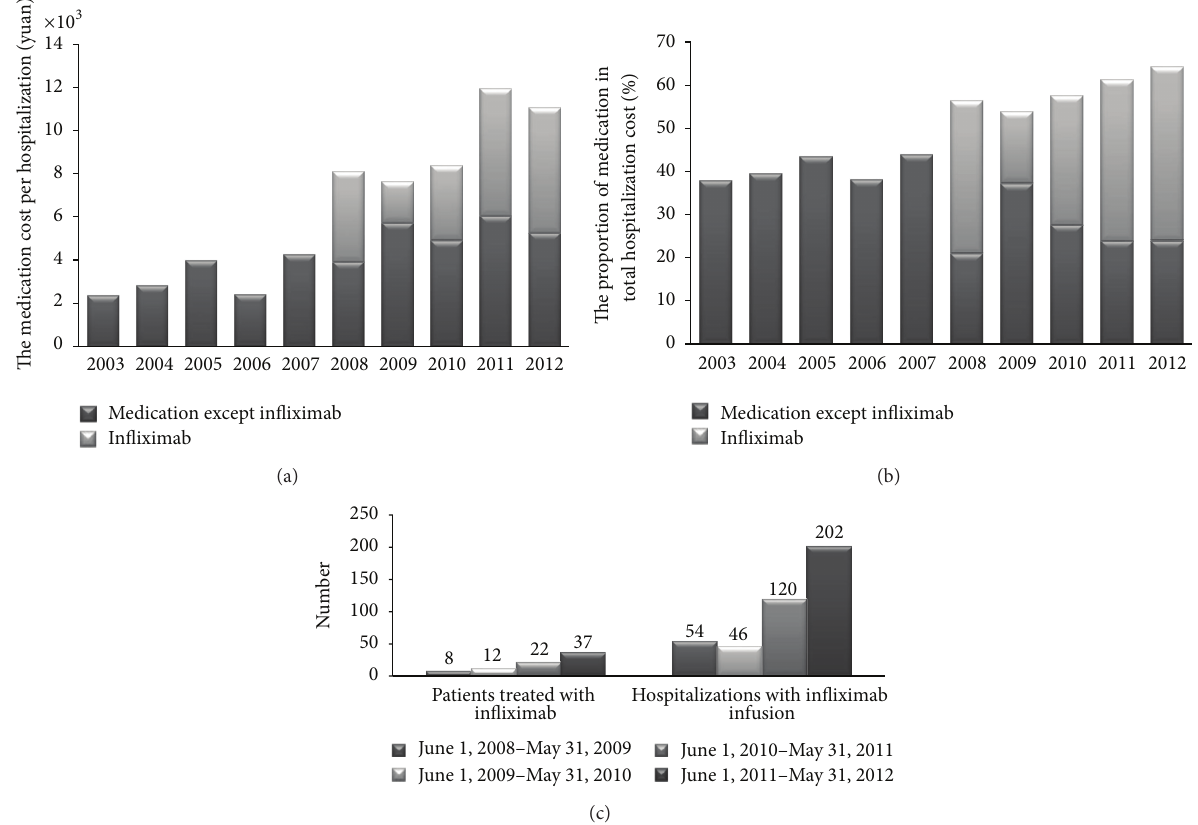
Figure 4: Medication and infliximab costs in IBD. (a) The medication cost per hospitalization; (b) the proportion of medication in total hospitalization cost; (c) the population of patients treated with infliximab and the number of hospitalizations with infliximab infusion.